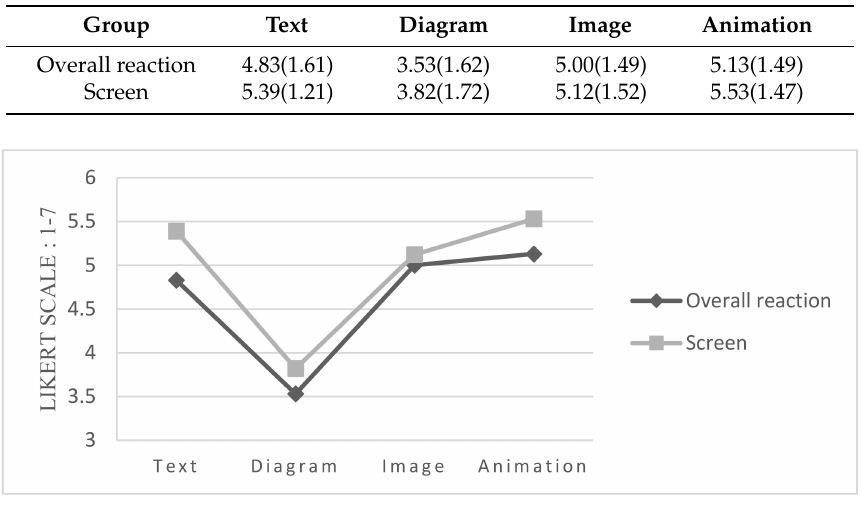
Figure 10. Overall reaction comparison (unit: points; seven-point Likert